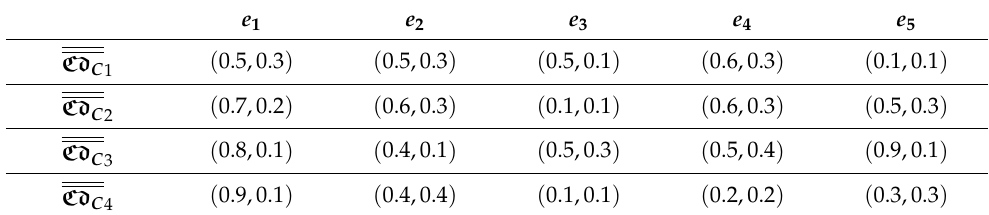
Table 3. Intuitionistic fuzzy soft matrix for Cd A 3